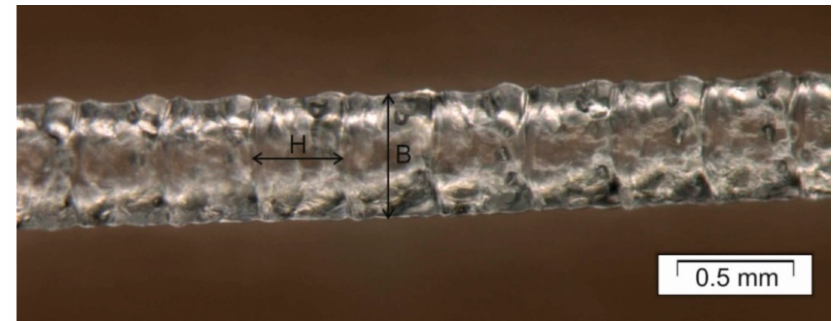
Figure 2. Micrograph of a string of droplets obtained using the initial printing conditions in Table 2. H values are from 0.22 to 0.25 mm and B values from 0.28 to 0.32 mm, giving a drop aspect ratio (DAR = B / H) of approximately